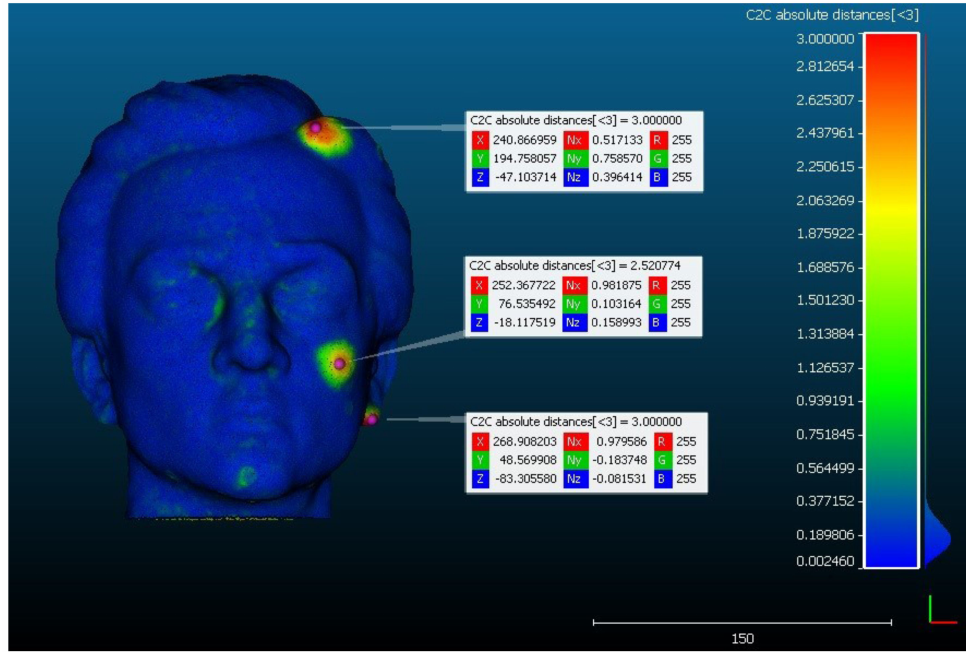
Figure 10. Results of the comparison of the models obtained by photogrammetry in CloudCompare